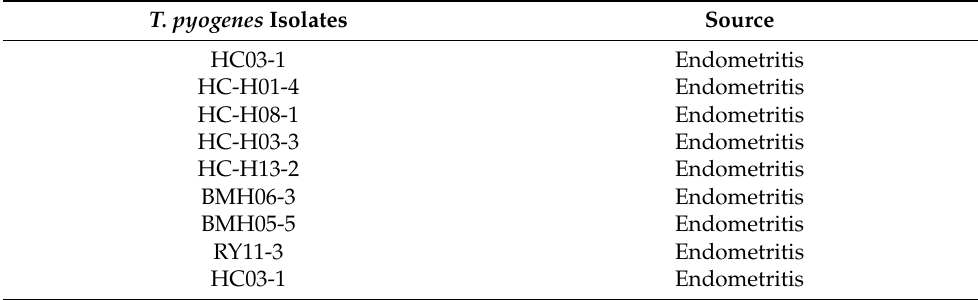
Table 3. Source of T. pyogenes isolates. T. pyogenes